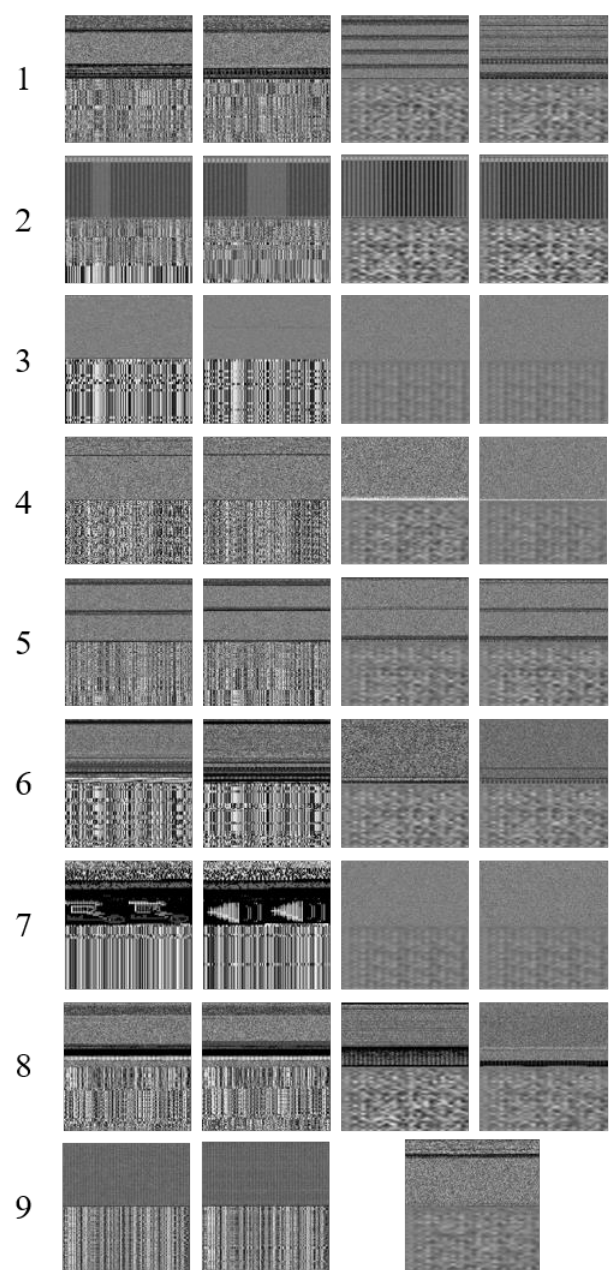
Figure 6. Merge results of global and local images.